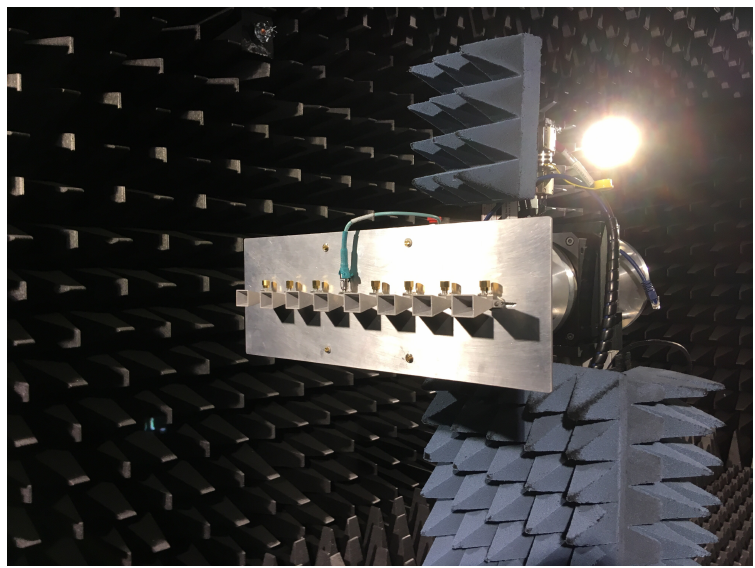
Figure 10. Picture of the array configured as a regular sparse array, mounted in the anechoic chamber.